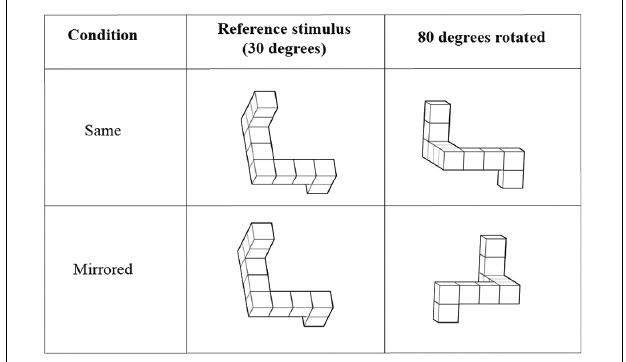
FIGURE 1 | Stimuli in the Mental Rotation Test. A reference stimulus is presented in every trial next to a rotated object. The task of the participant was to determine whether the presented objects were the same or mirrored version of each other. Extracted and modulated from Peters and Battista